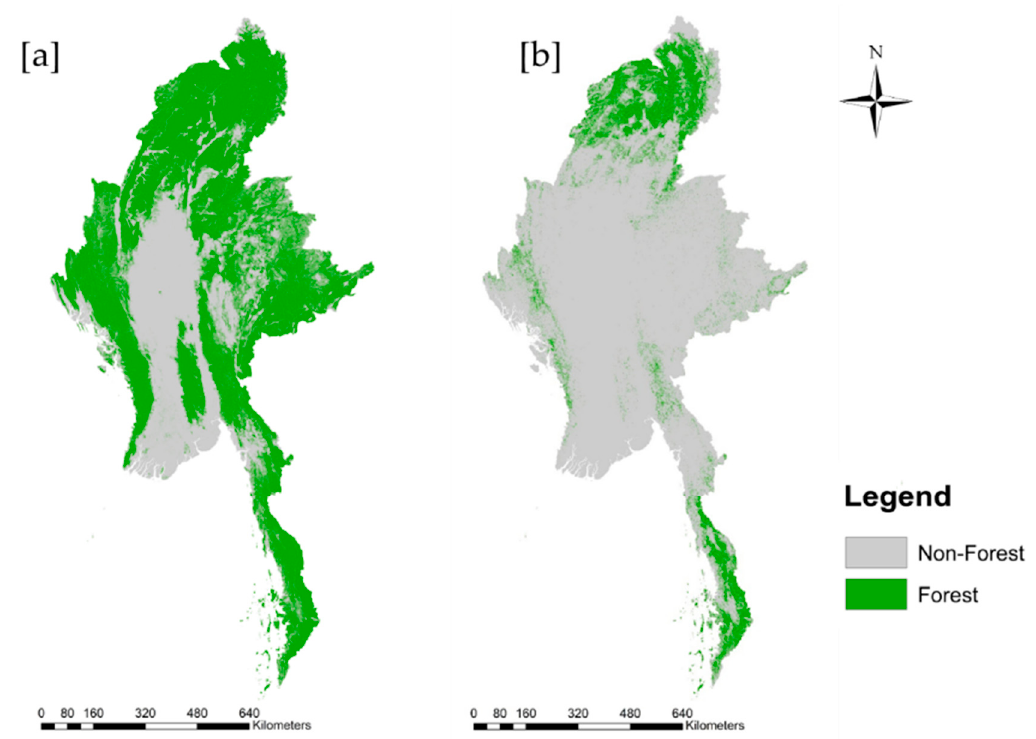
Figure 7. Forest cover maps for 2016 developed from the Global Forest Cover Database (GFCD) using average tree cover percent of neighboring pixels in 2000 [10] and ( a ) 40% tree cover threshold, or ( b ) 90% tree cover threshold.